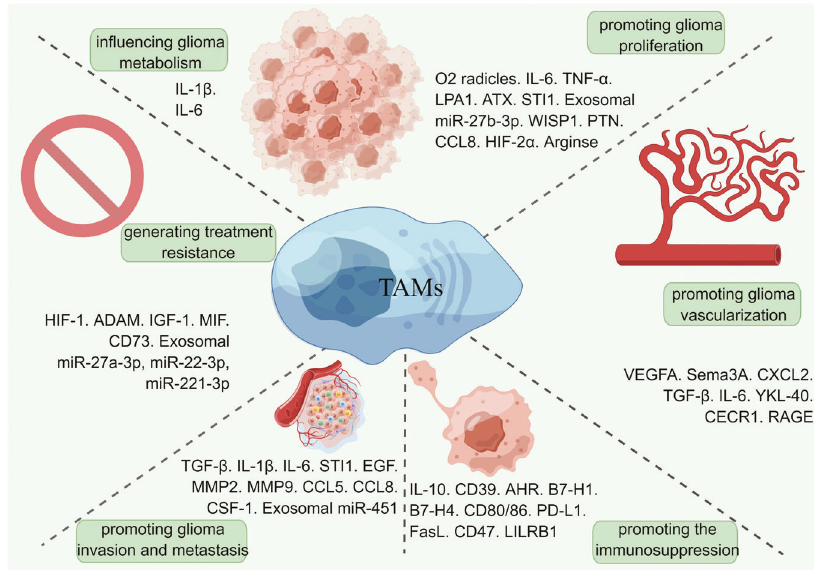
Fig. 3 Roles of TAMs in the TME and the molecules concerned. TAMs play a signi fi cant role in glioma progression by contributing to glioma proliferation, vascularization, and invasion, promoting immunosuppression in the GME, generating treatment resistance, and in fl uencing glioma metabolism. Acting through speci fi c signaling pathways, various molecules are closely involved. Detailed mechanisms are discussed as follows. (By